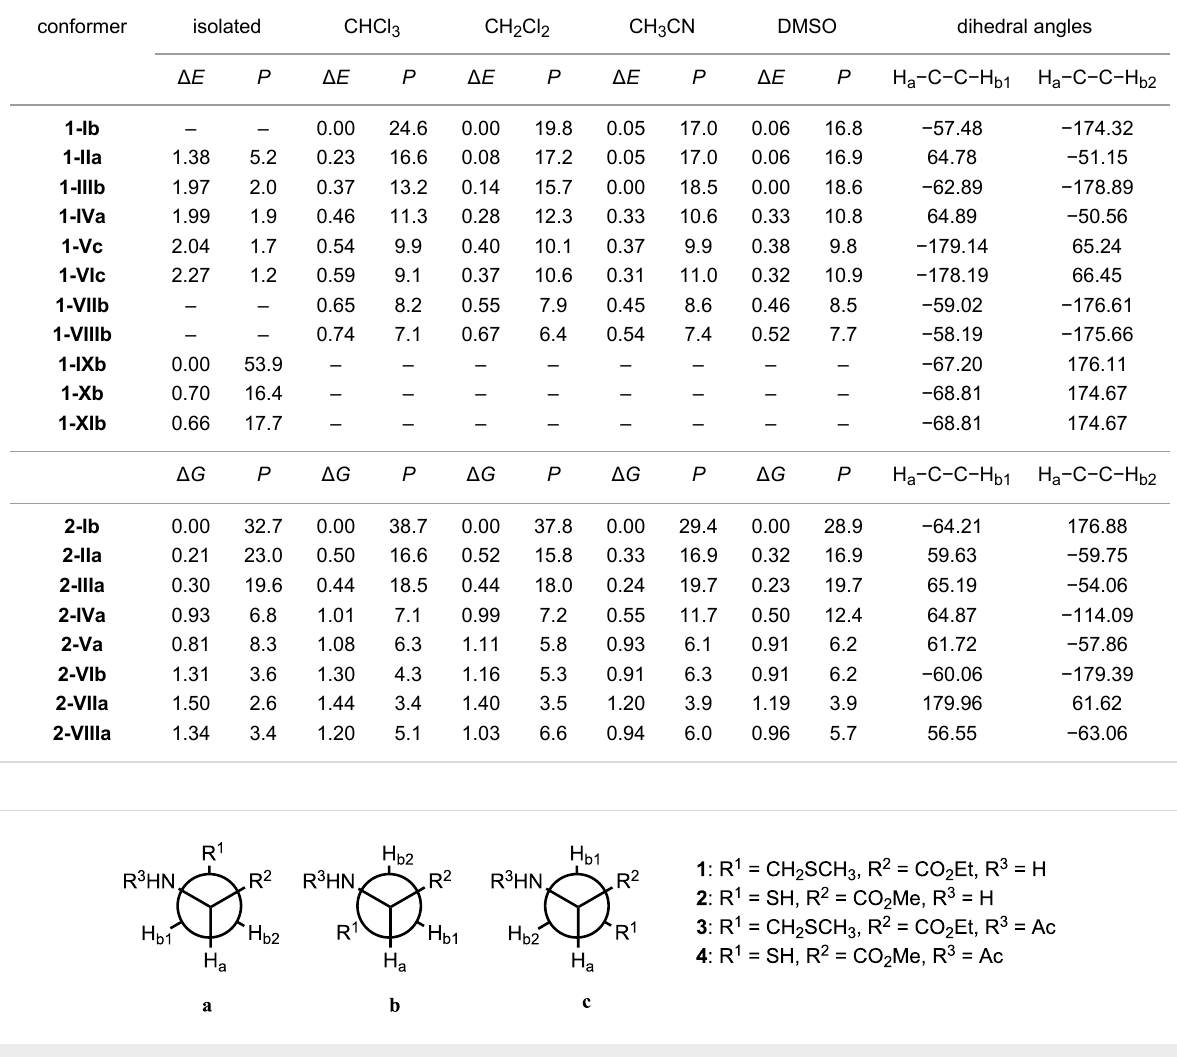
Figure 2: Three possible dispositions presented by geometries of the analyzed compounds 1 − 4 .